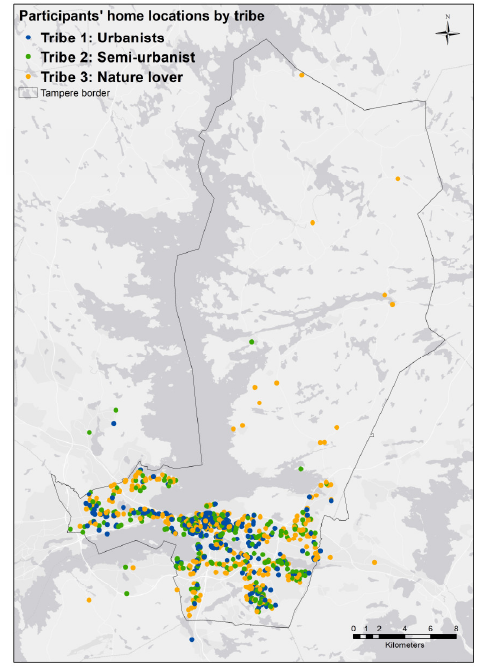
Figure 5. Participants’ dwelling